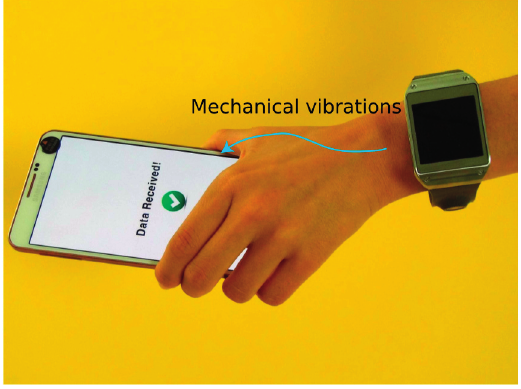
Figure 1. Proposed system that transmits data from a smartwatch to a touch device by modulating high-frequency mechanical waves. The signal is mechanically generated by the watch-mounted bone-conductor